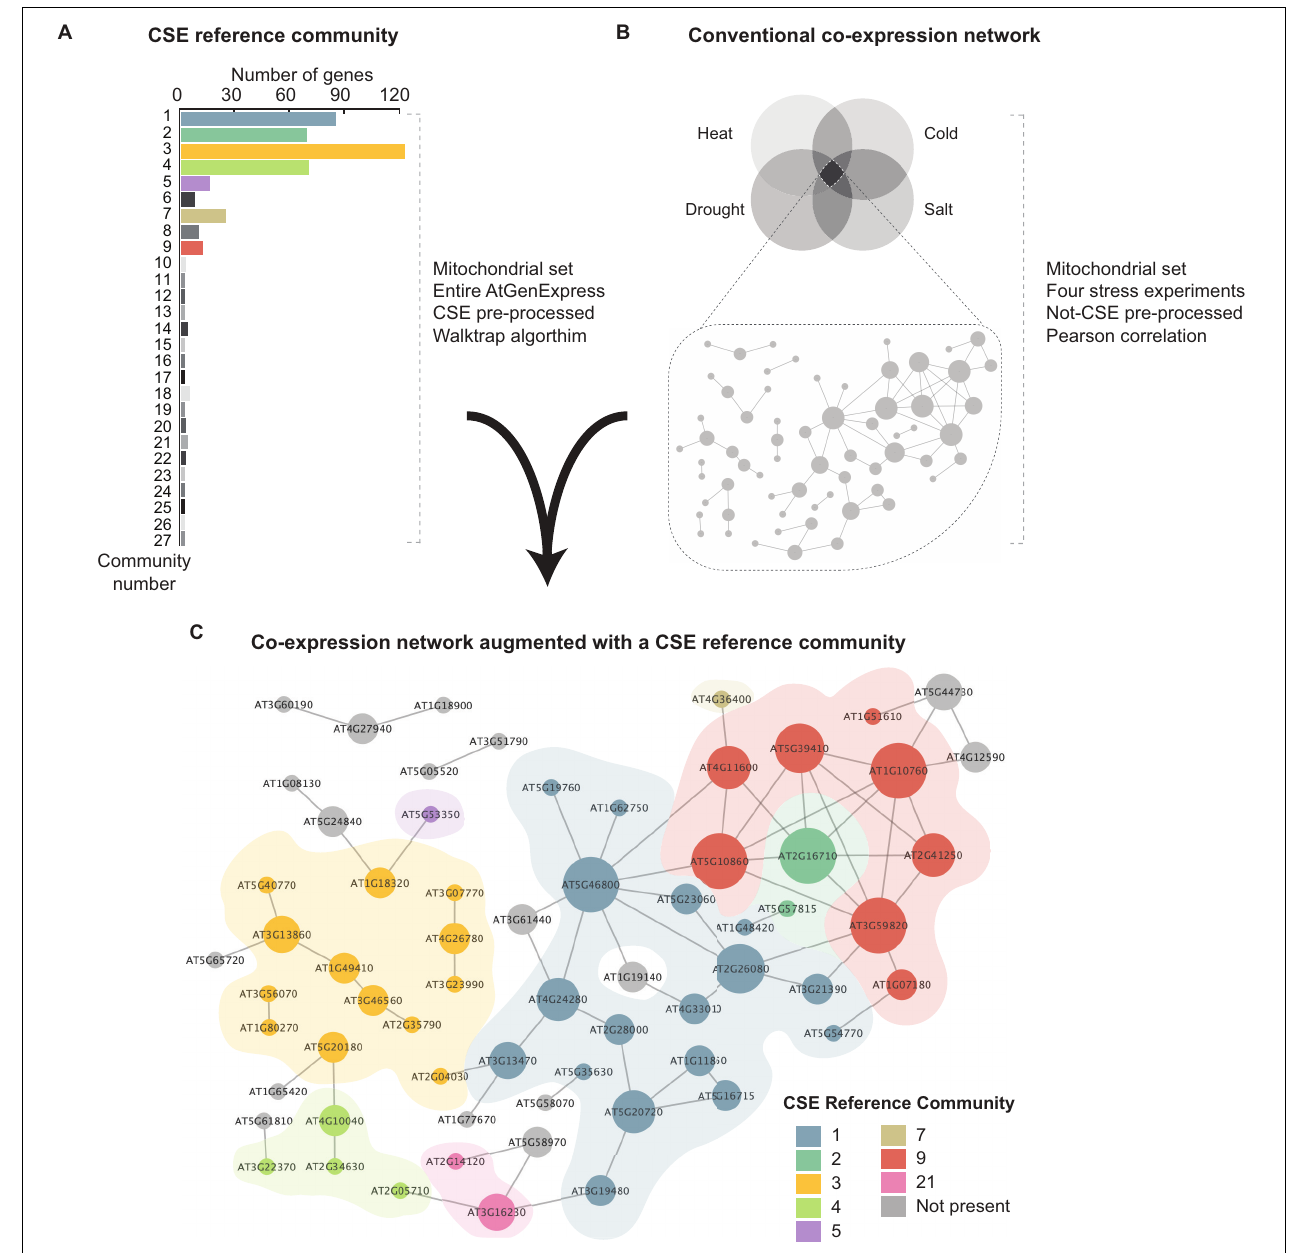
FIGURE 6 | Synthesis of a conventional co-expression network of Arabidopsis shoots common to four stresses with a CSE reference community. (A) A CSE reference community was generated utilizing the entire AtGenExpress Expression Atlas (Schmid et al., 2005; Kilian et al., 2007; Goda et al., 2008), using CSE pre-processed data. This network was divided into 27 primary clusters using a Walktrap community detection algorithm (Pons and Latapy, 2005). (B) A core set of stress-responsive genes was isolated from the AtGenExpress stress dataset (Kilian et al., 2007) covering heat, drought, cold, and salt stresses and from this, a network was generated based on Pearson correlation coefficient with no CSE. (C) The initial network of non-CSE core stress response generated using Pearson correlation coefficient was cross-referenced with the CSE reference community; providing deeper insight into the connectivity between genes, independent of outside influences such as stress or tissue type. The diameter of each node is proportional to the number of edges it has to a neighboring node and node coloration denotes occupation within a given CSE reference